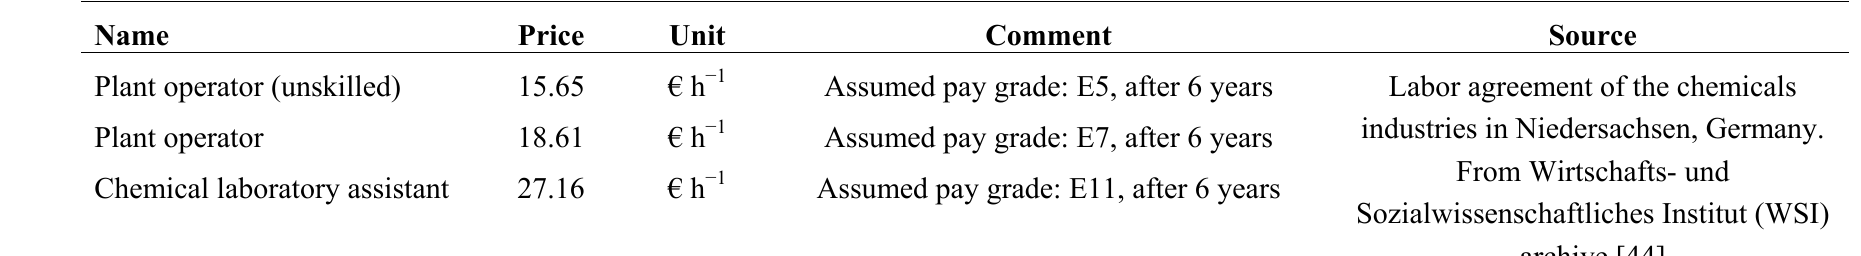
Table C-2. Adopted prices for personnel costs for the cost